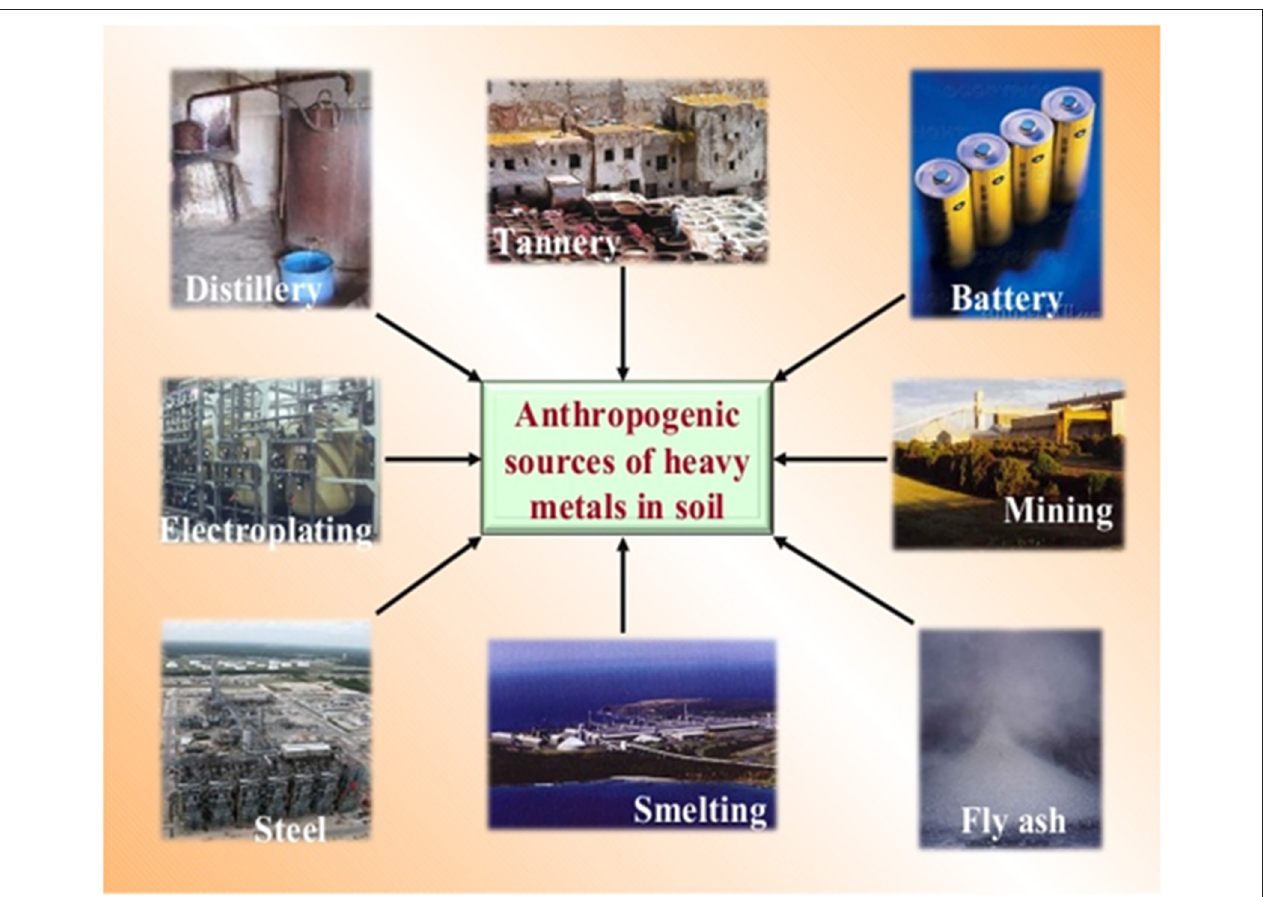
FIGURE 2 | Anthropogenic sources of heavy metals. (Source: https://www.slideshare.net/tutan2009/heavy-metal-pollution-in-soil-and-its-mitigation-aspect-by-dr- tarik-mitran).